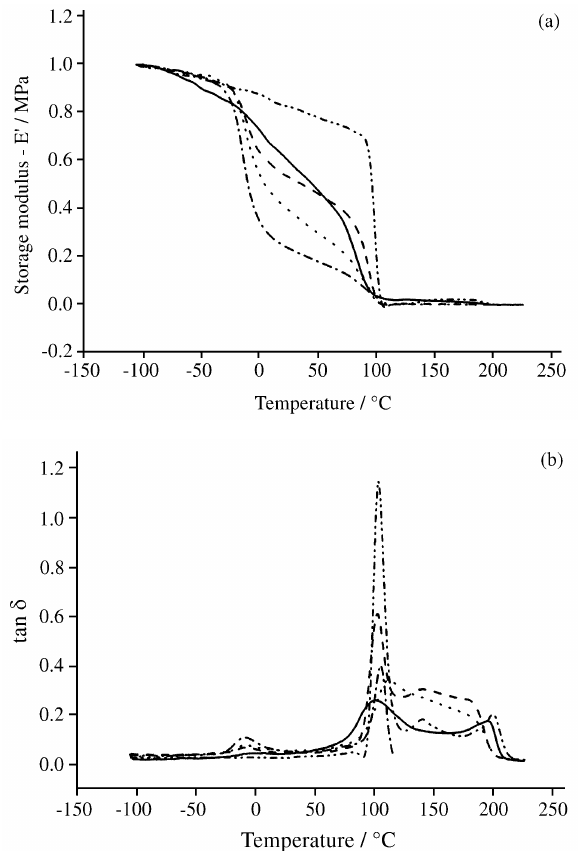
Figure 4. Dynamic-mechanical analysis for (-..-..-) pure PLLA, (-.-.-) pure PEO, (–) 80/20, (- - -) 50/50 and (. . . .) 20/80 PLLA/PEO blends (t = 0). (a) Storage modulus and (b) damping as a function of temperature.